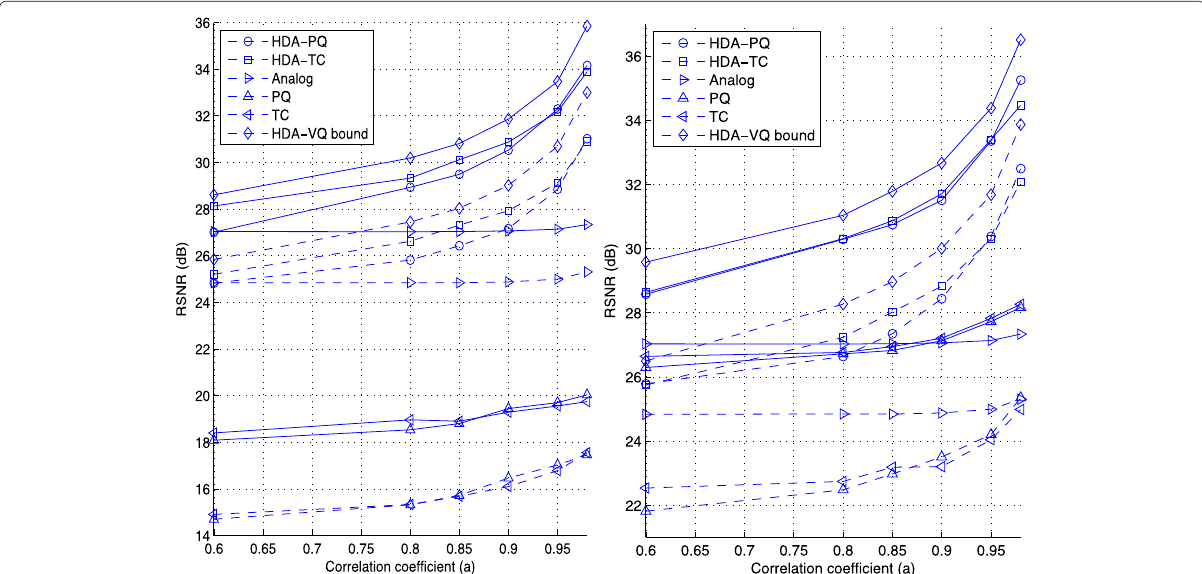
Fig. 5 Experimental RSNR of HDA systems for GM( a ) source, as a function of the correlation coefficient a at RX-CSNR = 20 dB. Left : ¯ θ = 15 dB, right : ¯ θ = 25 dB. Dash-lines : b = 3, solid-lines : b = 5. ρ and θ o values for HDA-PQ and HDA-TC systems shown here are listed in Tables 2 and 3. HDA-PQ prediction order is 1, and HDA-TQ transform block size is